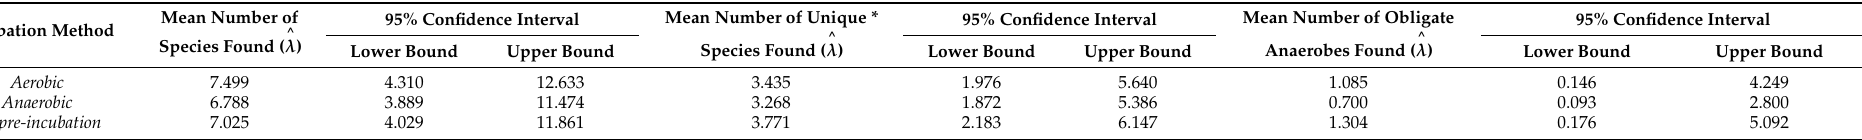
Table 3. Parameter estimates and confidence intervals found per incubation